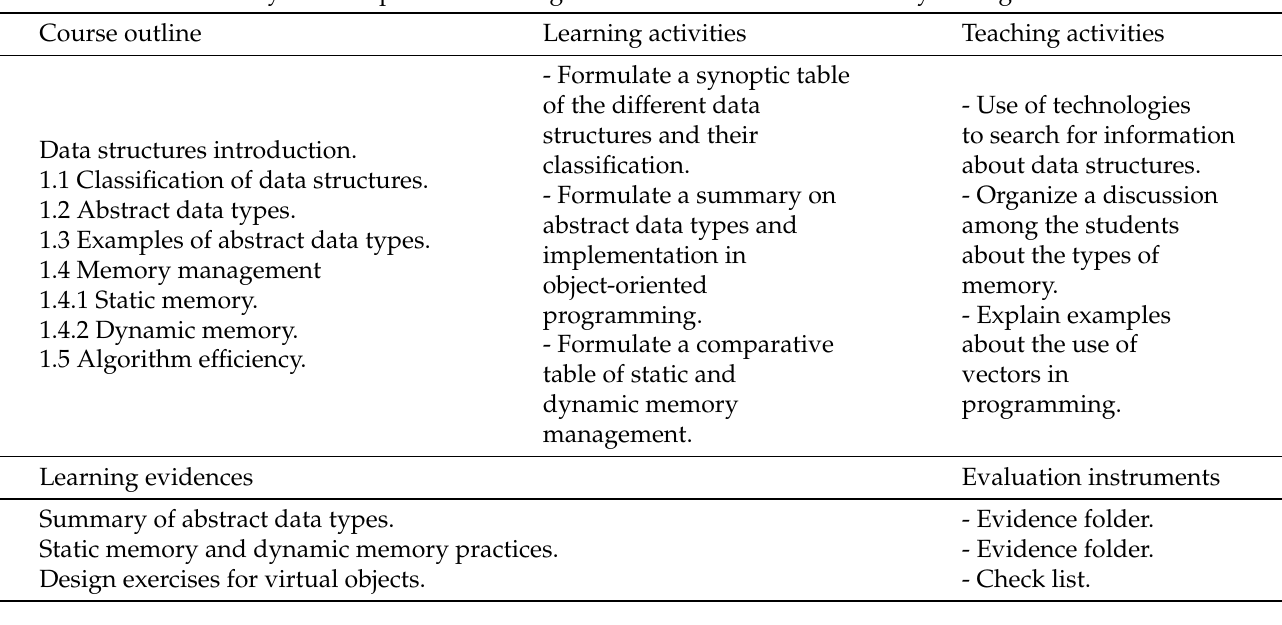
Table 4. Match of teaching